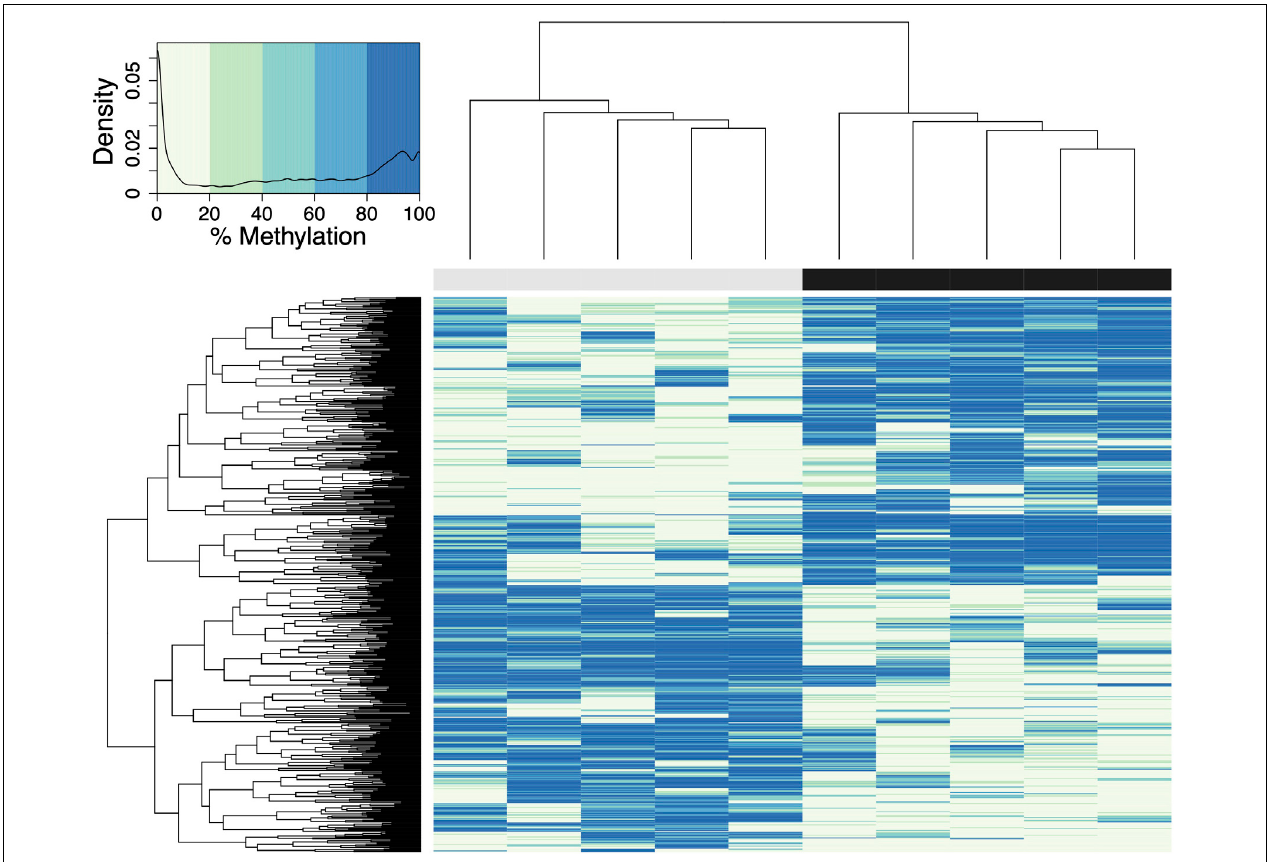
FIGURE 3 | Heatmap of DML in C. virginica reproductive tissue created using a euclidean distance matrix. Samples in control p CO 2 conditions are represented by gray, and samples in elevated p CO 2 conditions are represented by a black bar. Loci with higher percent methylation are represented by darker colors. A logistic regression identified 598 DML, defined as individual CpG dinucleotide with at least a 50% methylation change between treatment and control groups, and a q -value < 0.01 based on correction for false discovery rate with the SLIM method. The density of DML at each percent methylation value is represented in the heatmap